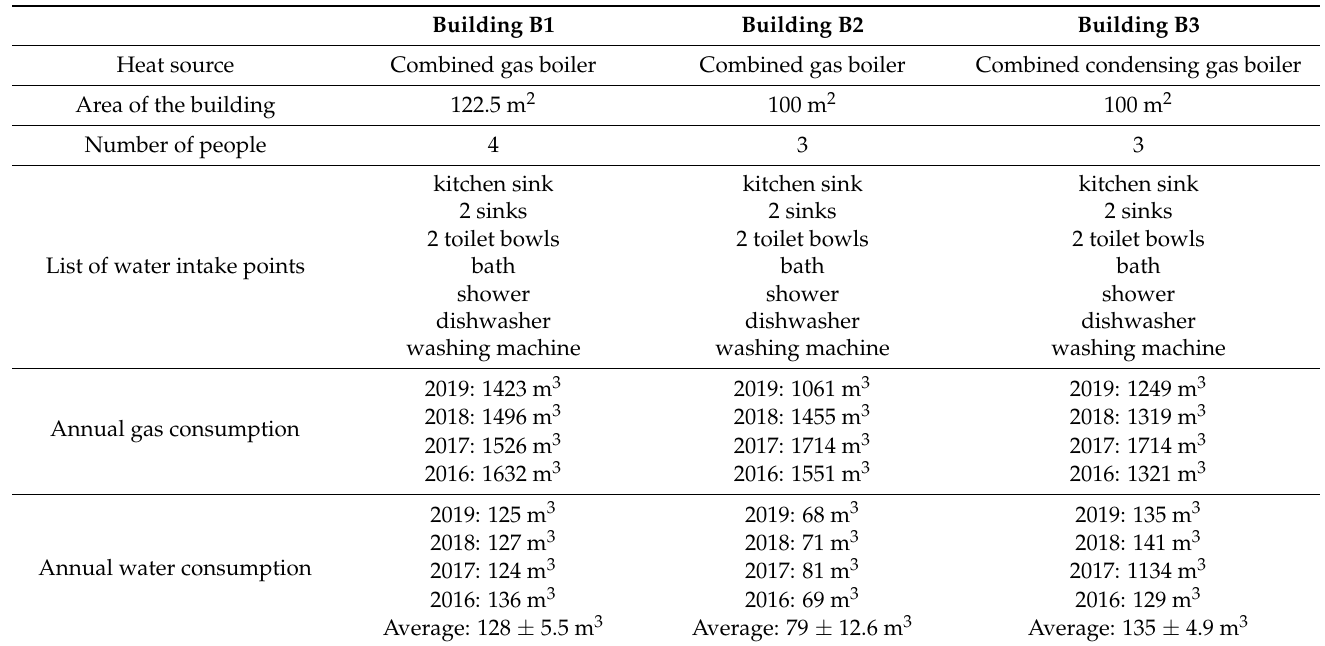
Figure 5. Diagram for calculating the energy rating and the impact of various water consumption indicators on the calcu- lated PE indices.